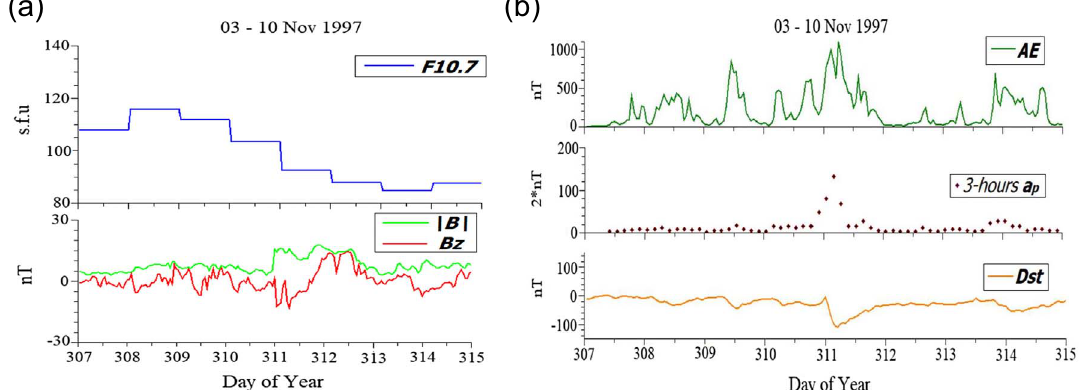
Fig. 6. In panel (a), from up to down, the solar fl ux F10.7 from 03 to 10 November 1997, and, for the same time period, the behaviour of the magnitude and the Z component of the IMF. Panel (b) shows, from up to down, the AE , the a p and the Dst indices, from 03 to 10 November 1997. (The hourly AE index data are retrieved through the Kyoto AE index service http://wdc.kugi.kyoto-u.ac.jp/dstae/index.html. Three-hour a p data are provided by NOAA ftp://ftp.ngdc.noaa.gov/STP/GEOMAGNETIC_DATA/INDICES/KP_AP. Dst and Solar data are obtained from